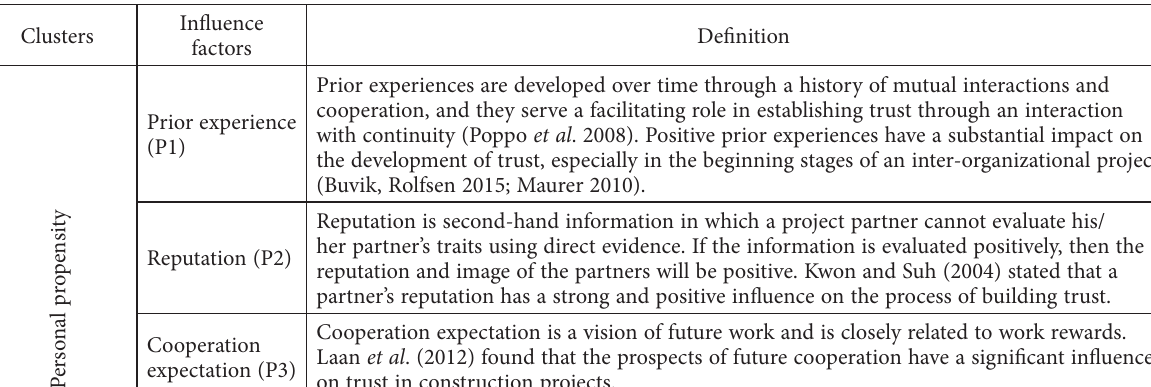
Table 1. Key factors influencing